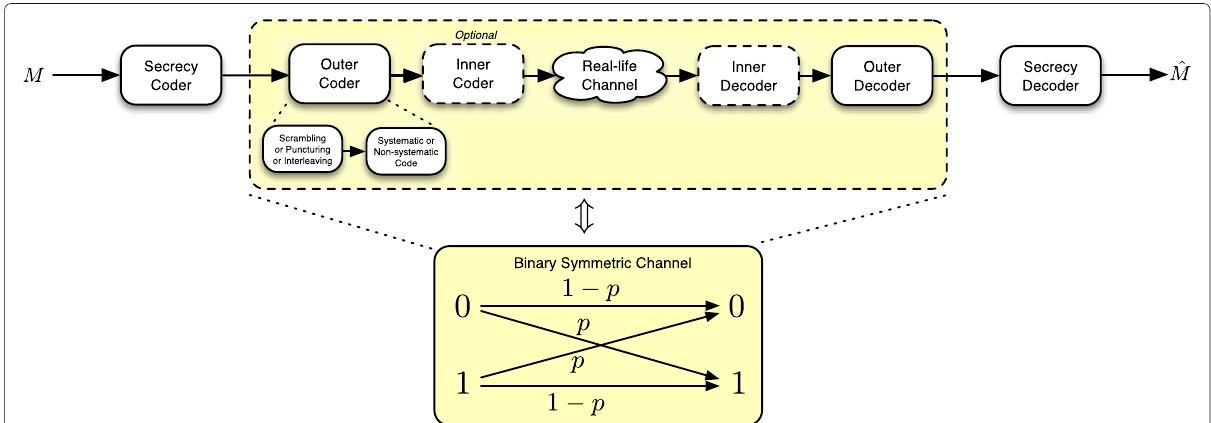
Fig. 8 A concatenated coding scheme may be utilized to provide an effective discrete memoryless wiretap channel, over which known explicit secrecy codes may operate for information-theoretic security